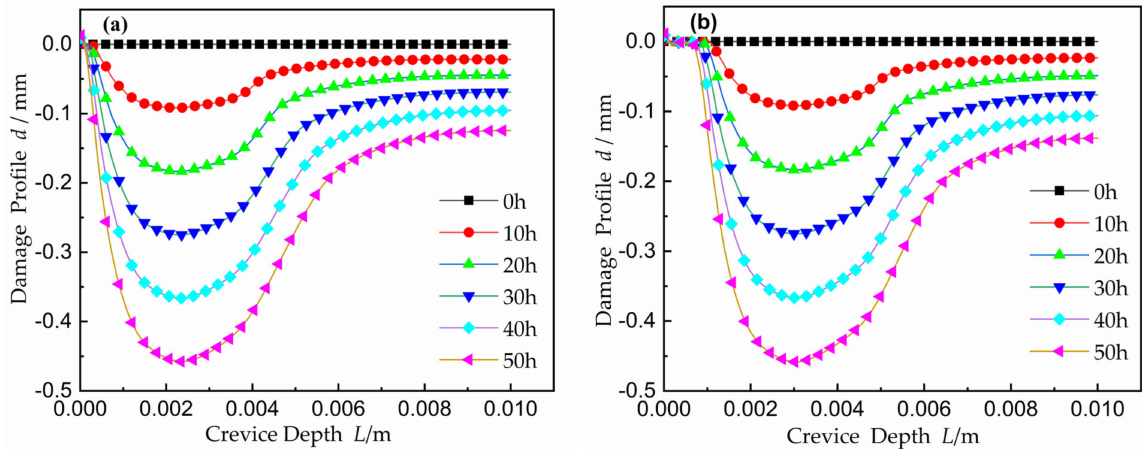
Figure 10. The crevice damage evolution inside the gap over time. ( a ) the applied potential E A = 0.25 V; ( b ) the applied potential E A = 0.30